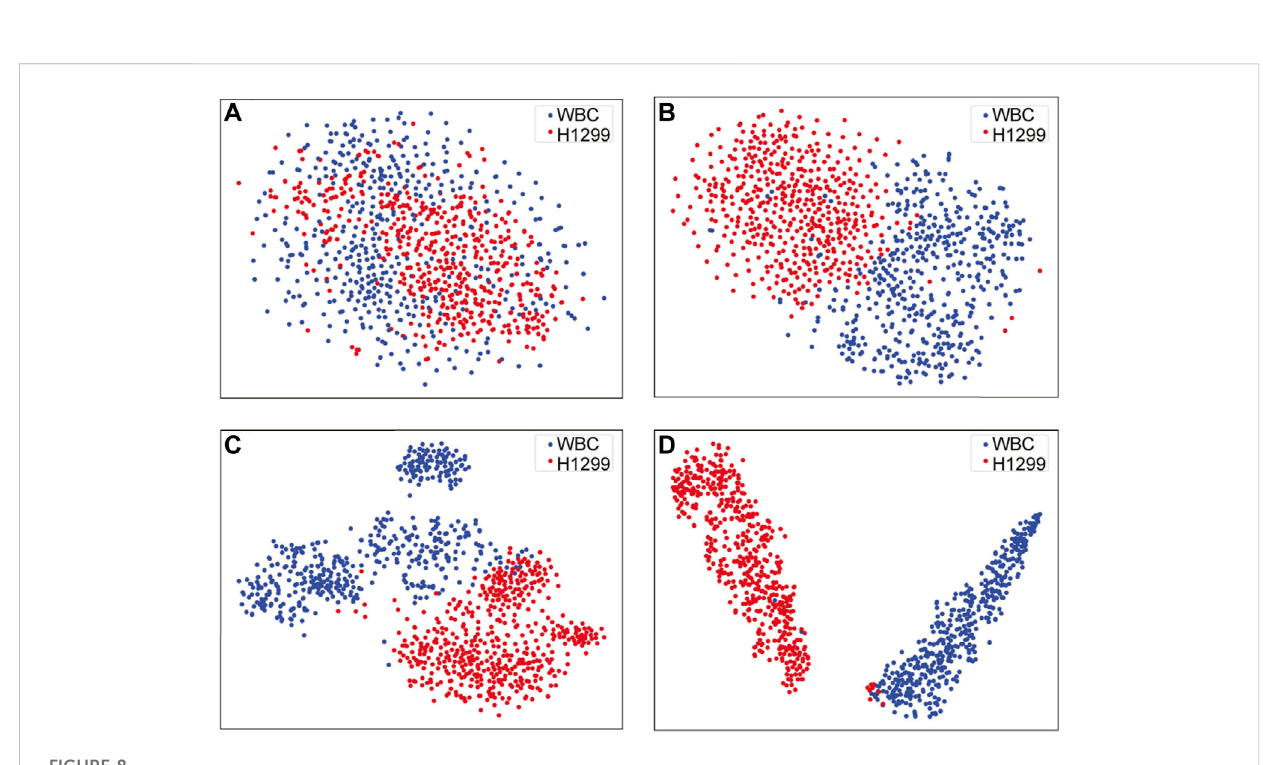
where the distribution of data and features were constructed in t-space. As shown in Figure 8, where result A was the original data distribution that directly obtained from the input image of